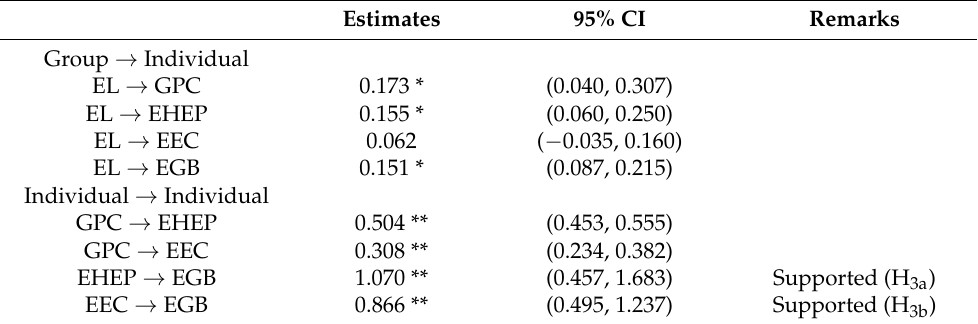
Table 3. Summary of direct effects.